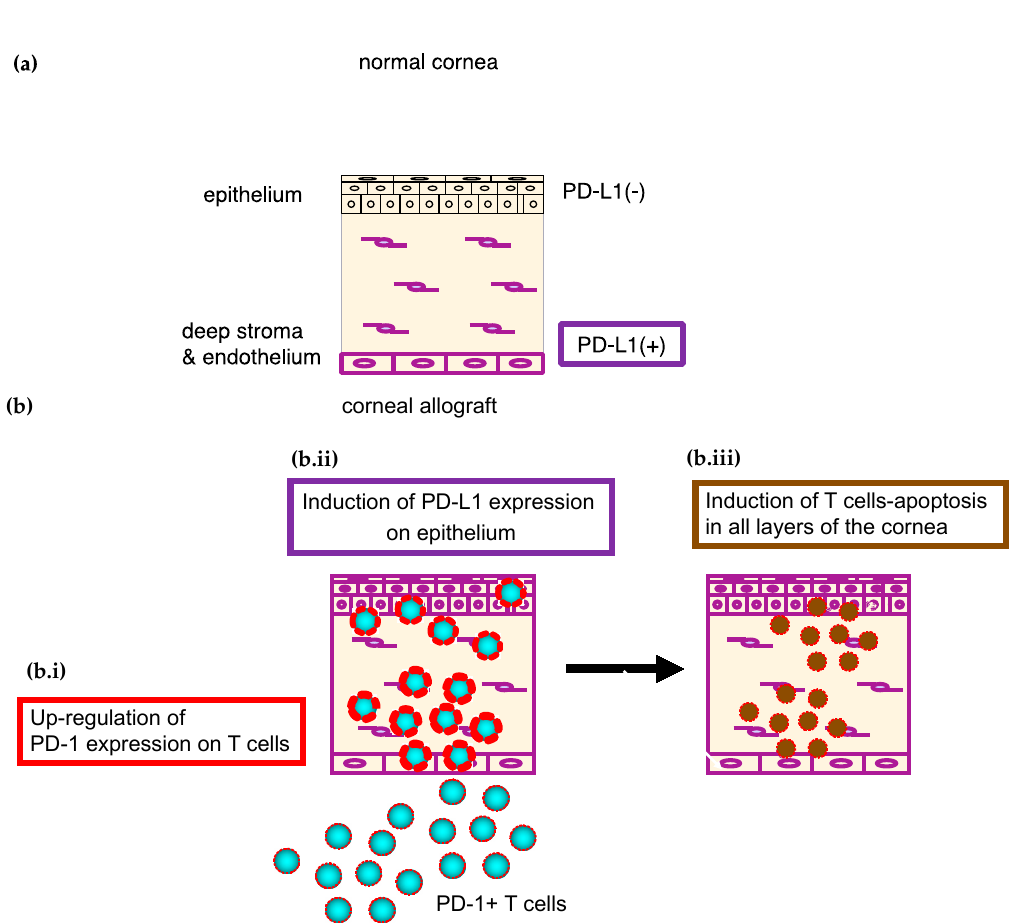
Figure 2. PD-L1 / PD-1-mediated T-cell apoptosis in the cornea. ( a ) PD-L1 is constitutively expressed in endothelial cells and some stromal cells, but not in epithelial cells. ( b ): (b.i) PD-1 expression on the surface of T cells is up-regulated after contact with the corneal cells. (b.ii) PD-L1 expression on epithelial cells is induced in the presence of IFN- γ . (b.iii) T-cell apoptosis mediated by PD-L1 and PD-1 is thus induced in each of the layers (epithelium, stroma and endothelium) of the cornea. Reprinted from Prog Retin Eye Res. 72, 100758. Hori, J.; Yamaguchi, T.; Keino, H.; Hamrah, P.; Maruyama, K. Immune privilege in corneal transplantation. Copyright (2019), with permission from Elsevier [3].